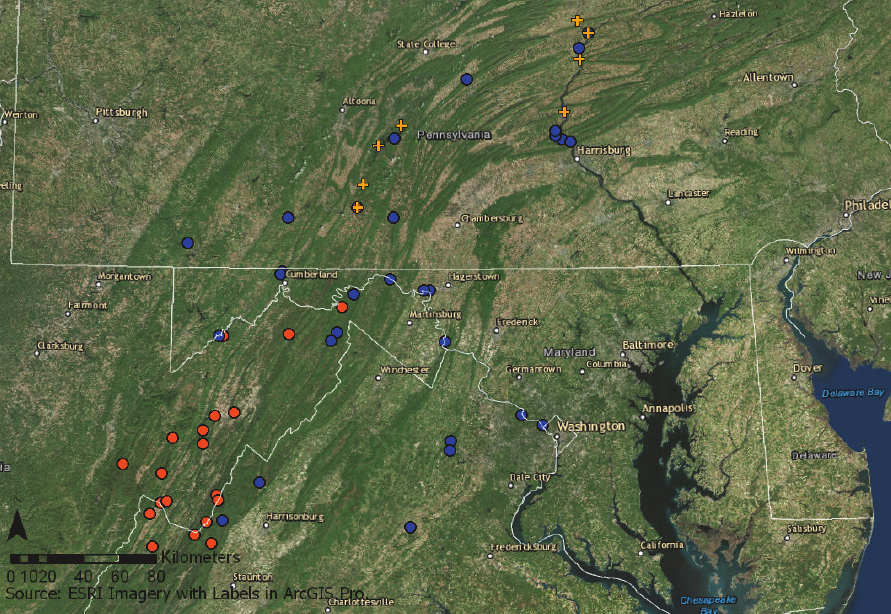
Figure 1. Range extent of Heuchera alba and Heuchera pubescens in the Appalachian Ridge and Valley. Orange circles indicate range and location of H. alba in WV and VA; Blue circles indicate partial range and location of H. pubescens ; Orange crosses represent new locations of H. alba in